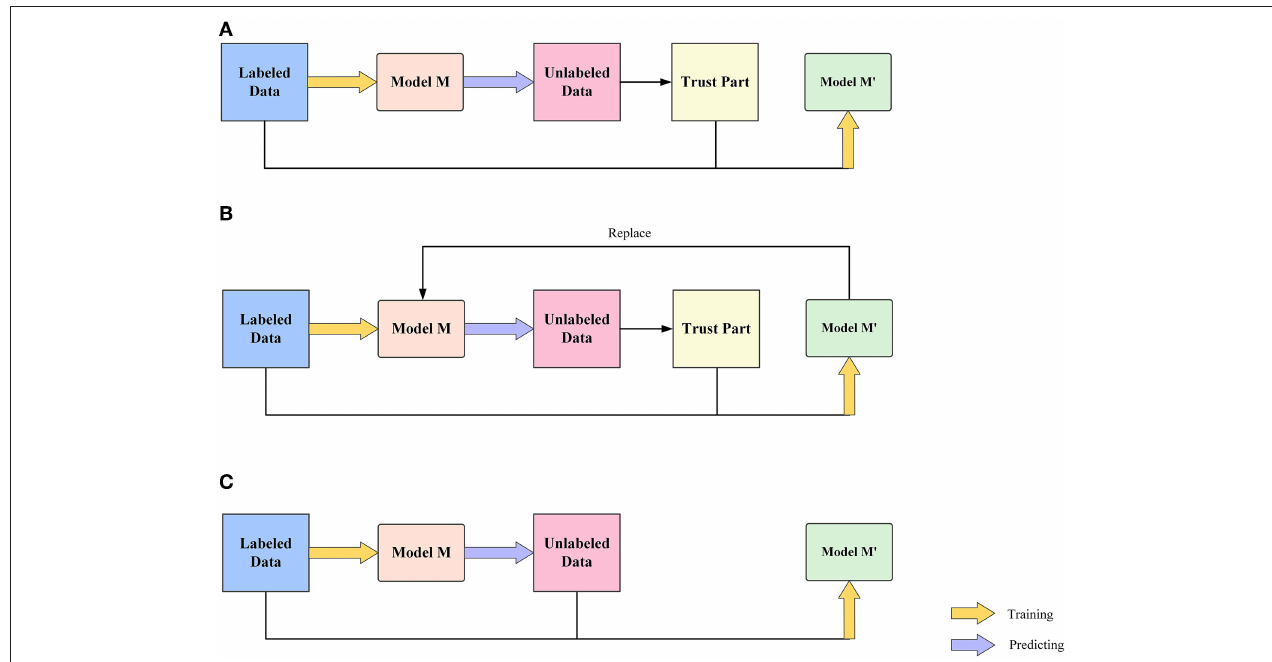
FIGURE 7 | Flow chart of three pseudo-label models: (A) Model include the step of placing the model prediction labels into the Trust Part, (B) Model include the step of placing the prediction labels intro the Trust Part, also with iterative process, and (C) Model without the step of placing the model prediction labels into the Trust